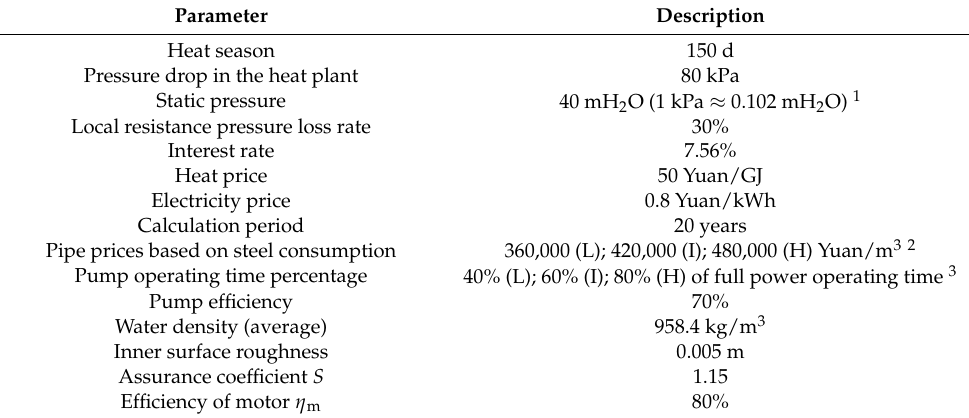
Table 2. Relevant parameters used in the optimization